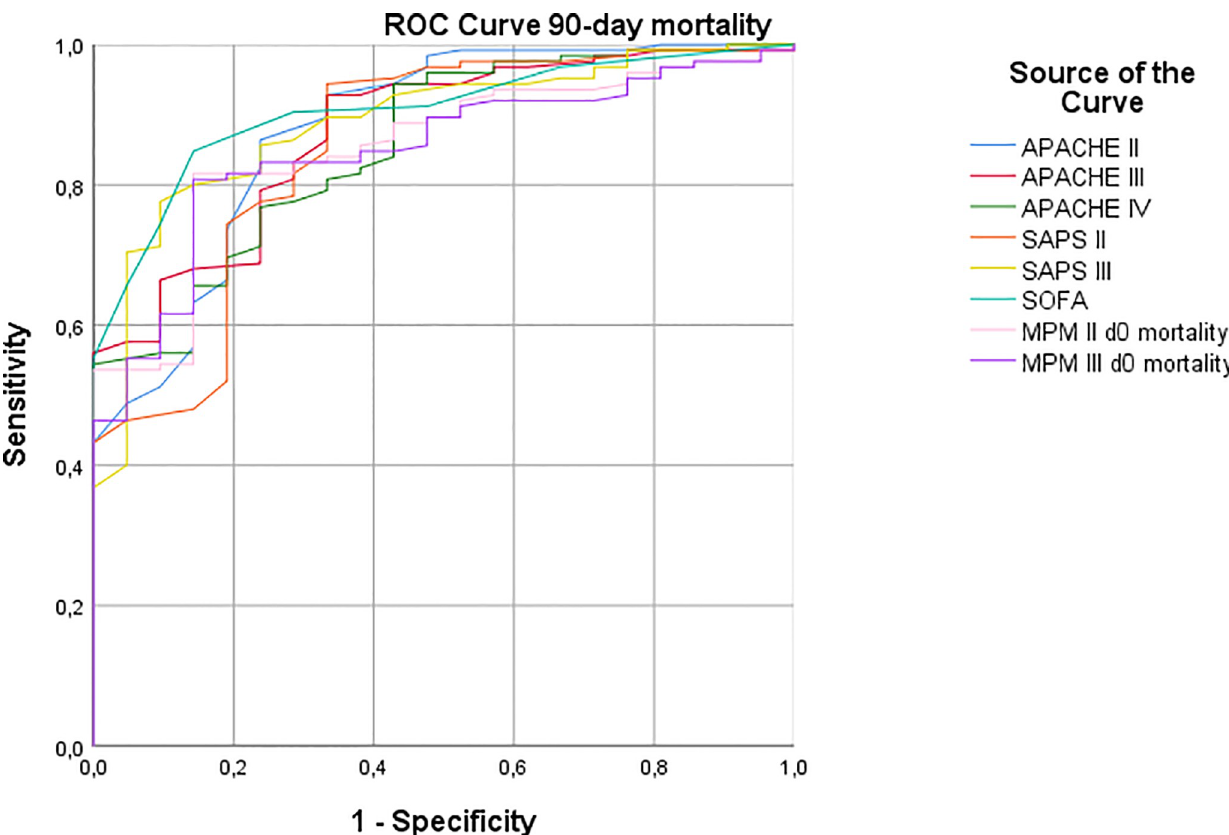
Fig 2. ROC curve analysis. 90-day mortality ROC curve of the tested predictive scores. APACHE: Acute Physiology Assessment and Chronic Health Evaluation, SAPS: Simplified Acute Physiology Score, SOFA: Sequential Organ Failure Assessment, MPM: Mortality Prediction Model.